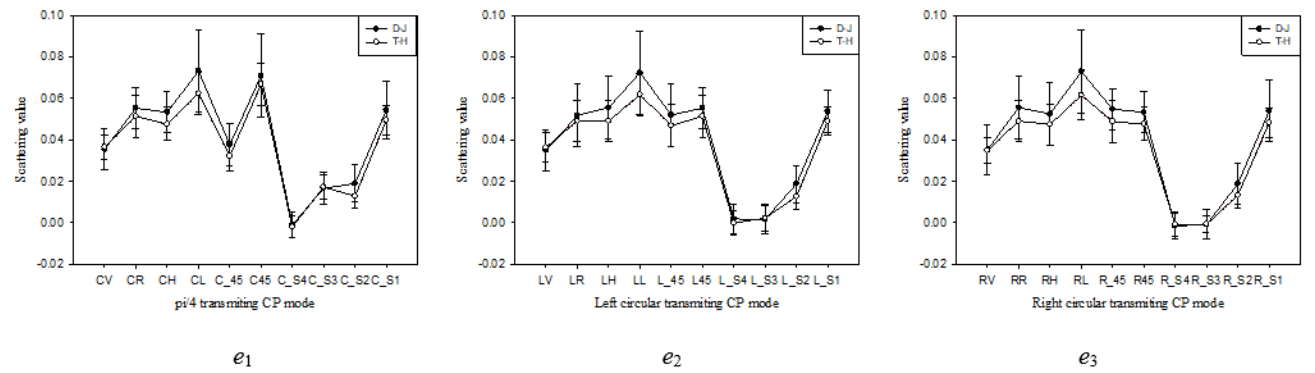
(( d 1 ): π /4 transmitting mode; ( d 2 ): left circular transmitting; ( d 3 ): right circular transmitting) on 16 September 2015 (0916 period).